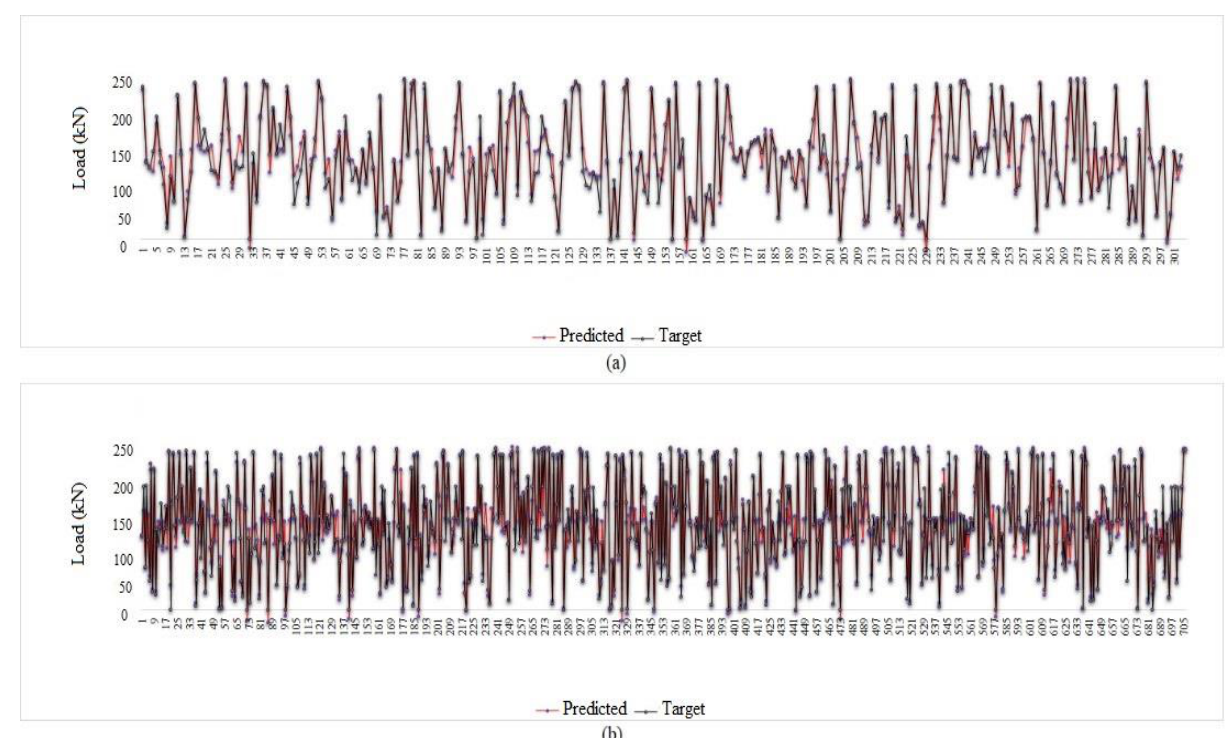
Figure 27. Tolerance diagram with respect to the RBF (seven inputs) prediction: ( a ) test phase, and ( b ) train phase.